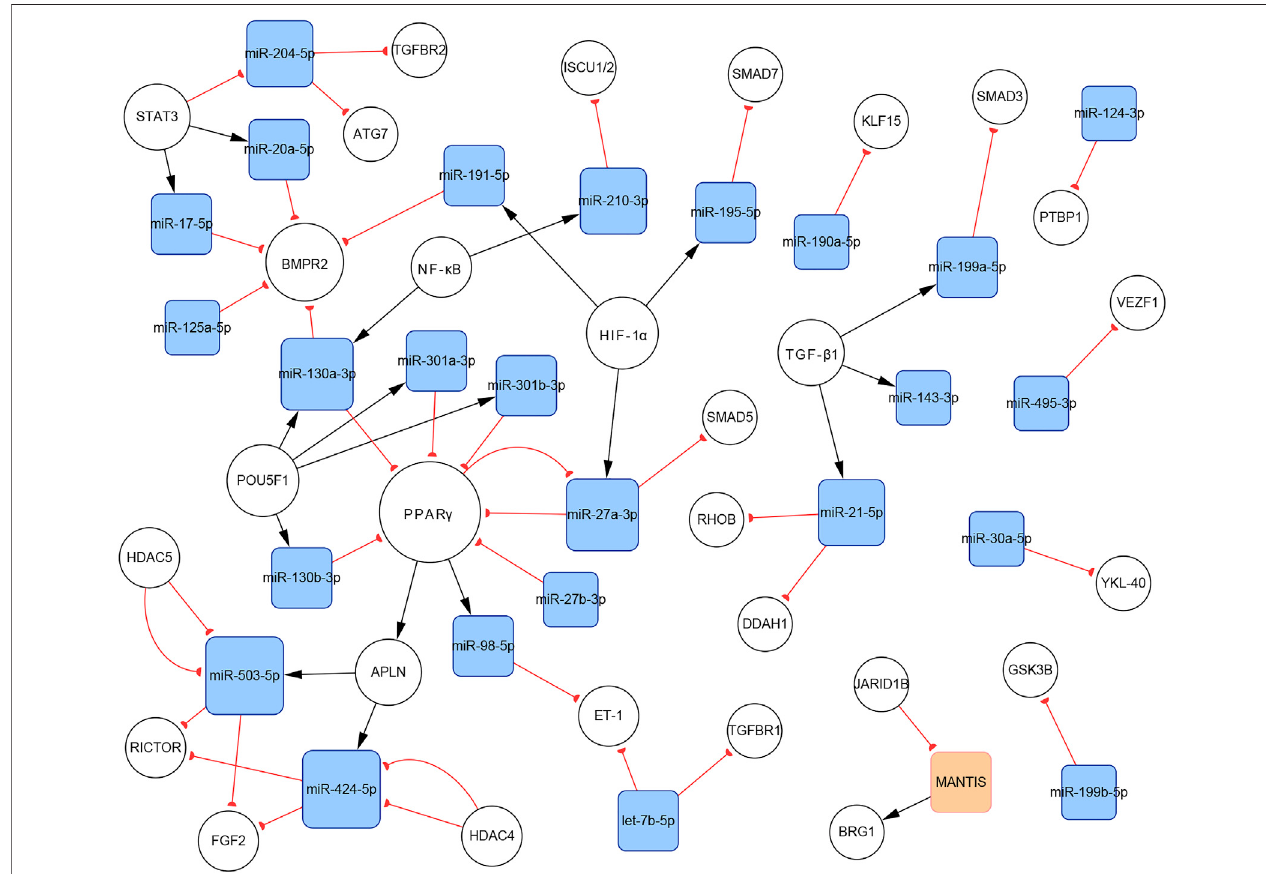
FIGURE 4 | The PH-associated network of ncRNAs and their interacting RNAs or genes in PAECs. The square and circular nodes represent ncRNAs and coding RNAs or genes, respectively. Node color is based on the type of molecule (lncRNAs are orange, miRNAs are blue, and coding RNAs or genes are empty). Node sizes represent the degrees (number of edges that directly link to the node). Edges represent regulatory connections. Each edge indicates a publication. When multiple publications describe one interaction, multiple edgesconnectthe sametwo nodes. Red edges depict links indicatingrepressiveaction (semicircular arrow heads), and black edges represent those indicating activation (traditional arrow heads). The nodes in this network were primarily involved in proliferation, apoptosis resistance, migration, and endothelial – mesenchymal transition. PAECs: pulmonary artery endothelial